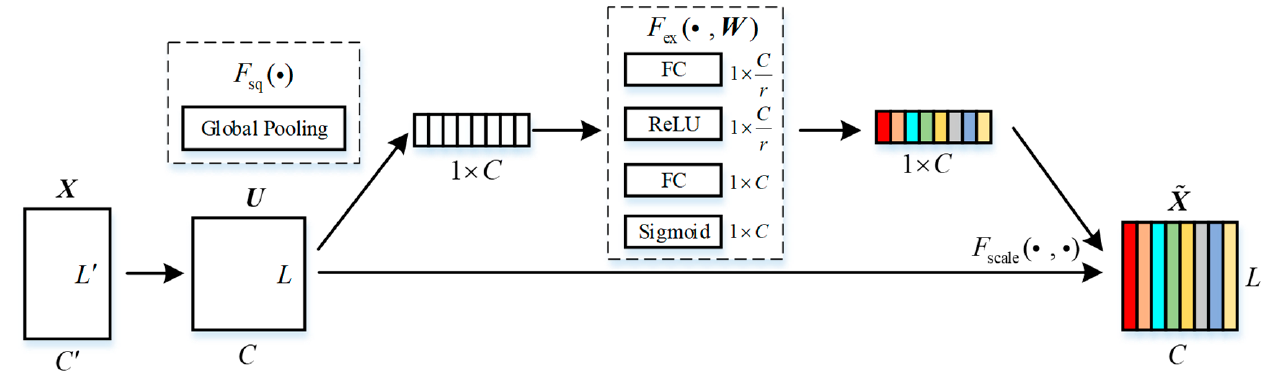
Figure 4. One-dimensional SE model.